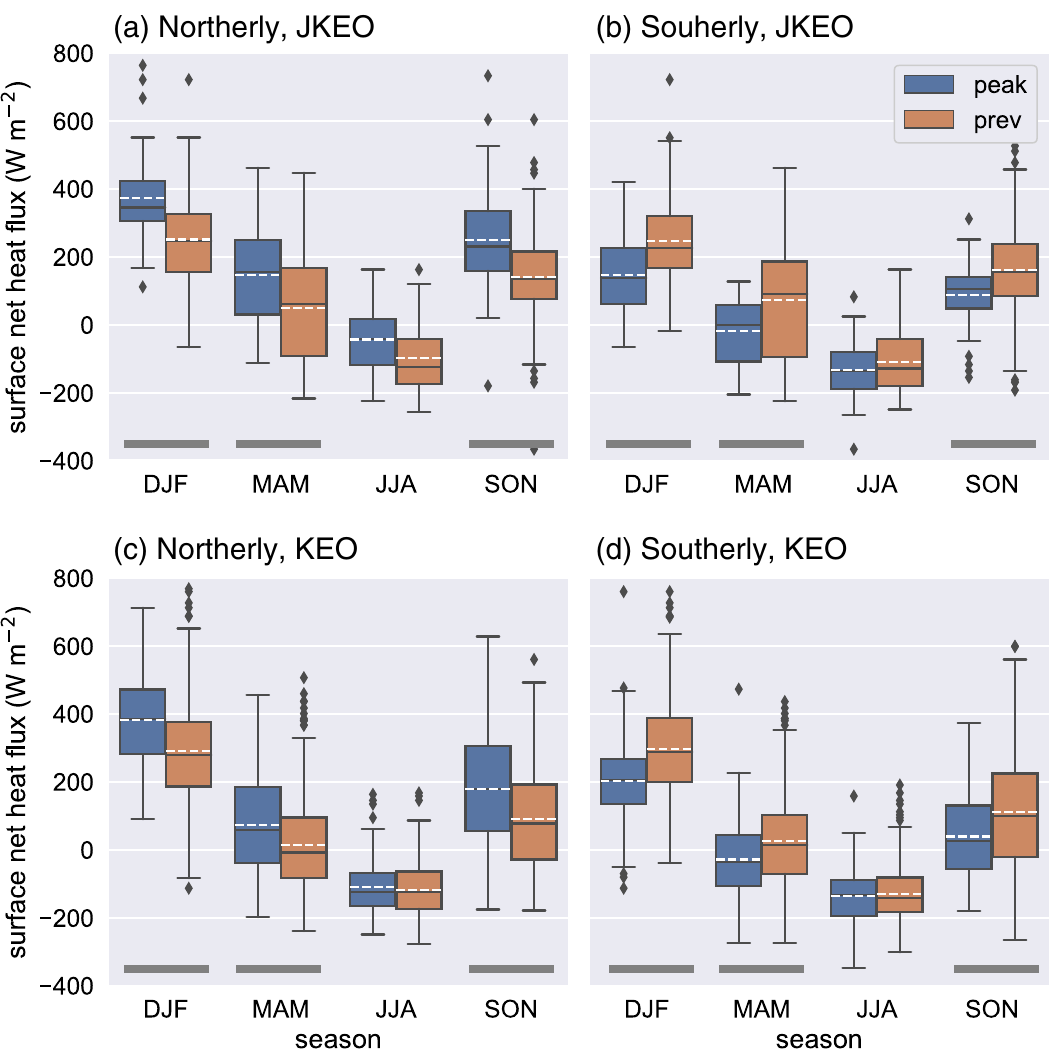
Figure 7. Seasonality of surface net heat flux response to the ( a , c ) northerly and ( b , d ) southerly wind events. The changes in the surface net heat flux between the peaks and its previous 3 days are shown as box plots for the two buoy sites: ( a , b ) JKEO and ( c , d ) KEO. Seasons are defined as four different periods: December, January, and February (DJF); March, April, and May (MAM); June, July, and August (JJA); and September, October, and November (SON). Significant differences (99%) between the peaks and its previous 3 days are indicated by a thick black bar at the bottom. The box plots were depicted with the minimum, the maximum, the median, and the first and third quartiles. The white dashed lines and black diamonds are showing means and